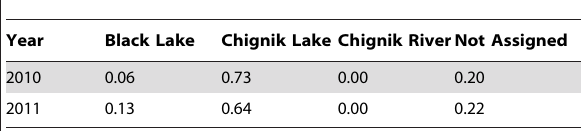
Table 1. The proportion of the sample in each year assigned to each stock group at the 80% probability